Question: Name the type of graph shown.
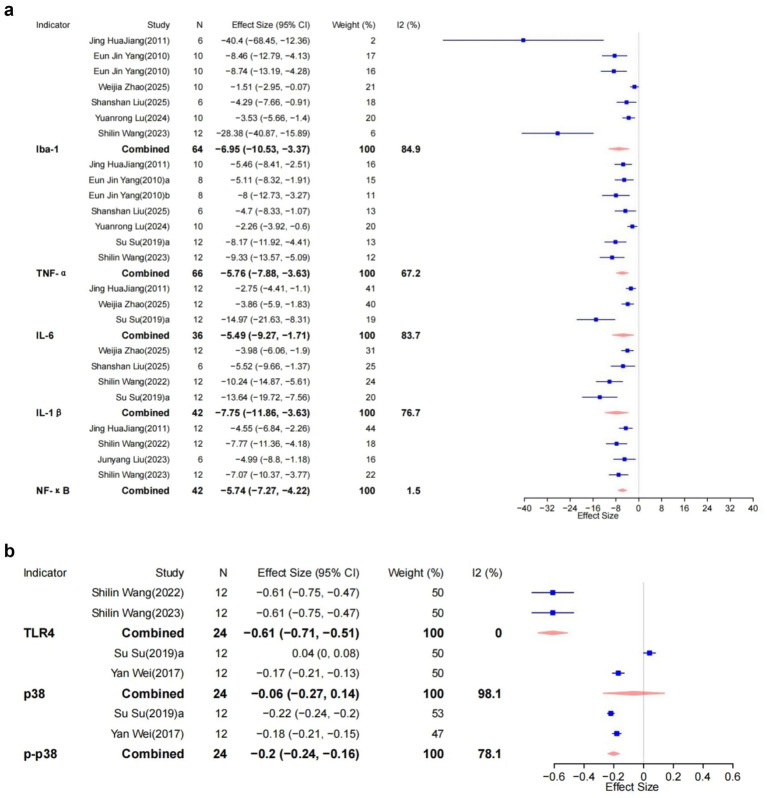
Answer: forest